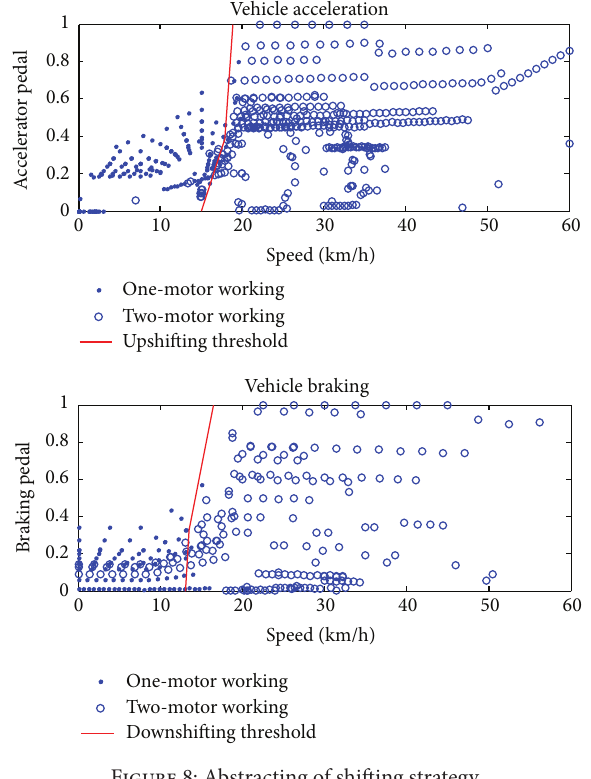
Figure 8: Abstracting of shifting strategy.